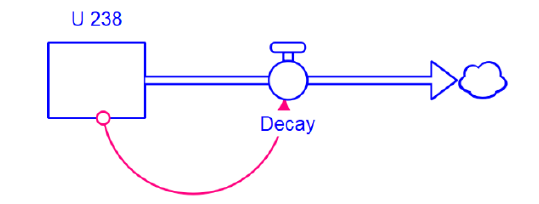
Fig. 7. Stock-and-flow for U-238 spontaneous decay